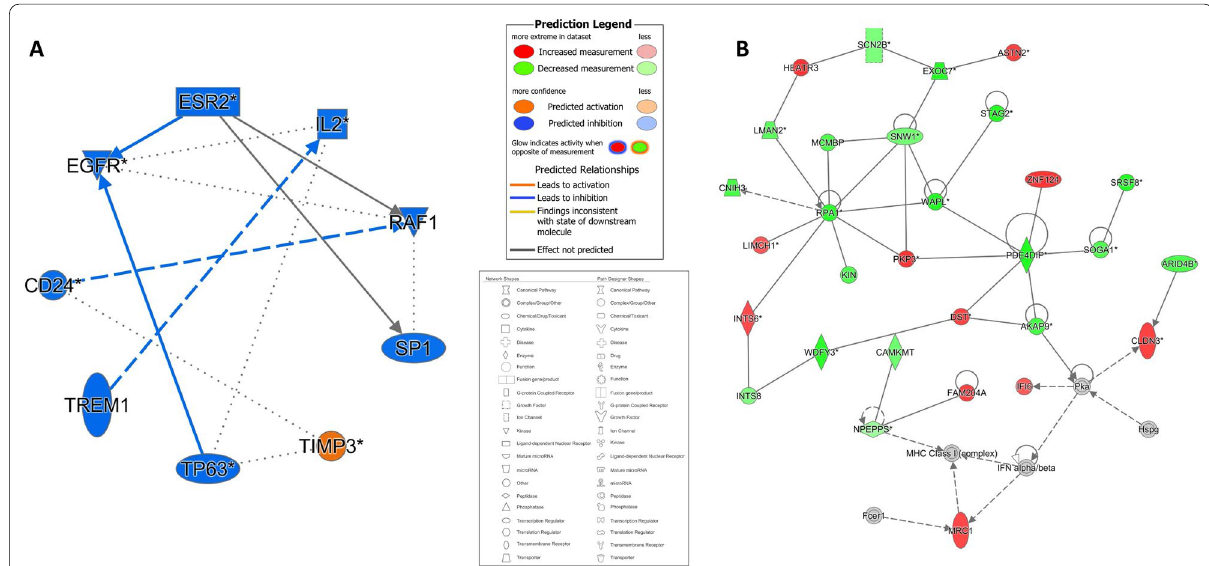
Fig. 3 A Graphical summary and B interaction network analysis of differentially expressed genes in smoker buccal mucosa. Different shapes represent the molecular class of the protein. Red and green indicate upregulation and downregulation, respectively, while blue and orange indicate inhibition and activation, respectively. A solid line indicates a direct interaction, a dashed line indicates an indirect interaction, and a dotted line indicates inferred correlation from machine‑based learning. An asterisk indicates that multiple identifiers in the dataset file map to a single gene or chemical in the Global Molecular Network